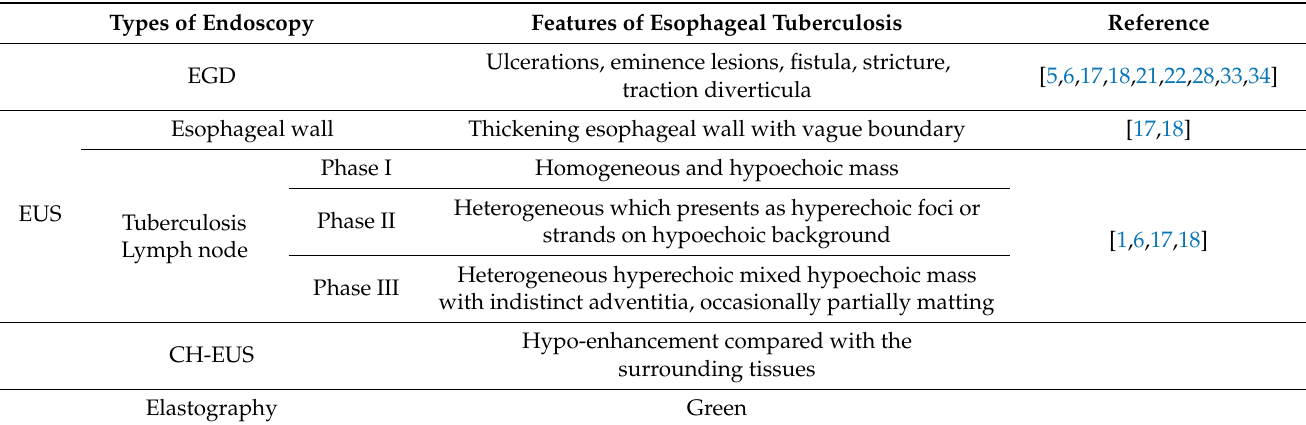
Table 2. Role of different types of endoscopies in the diagnosis of esophageal tuberculosis.